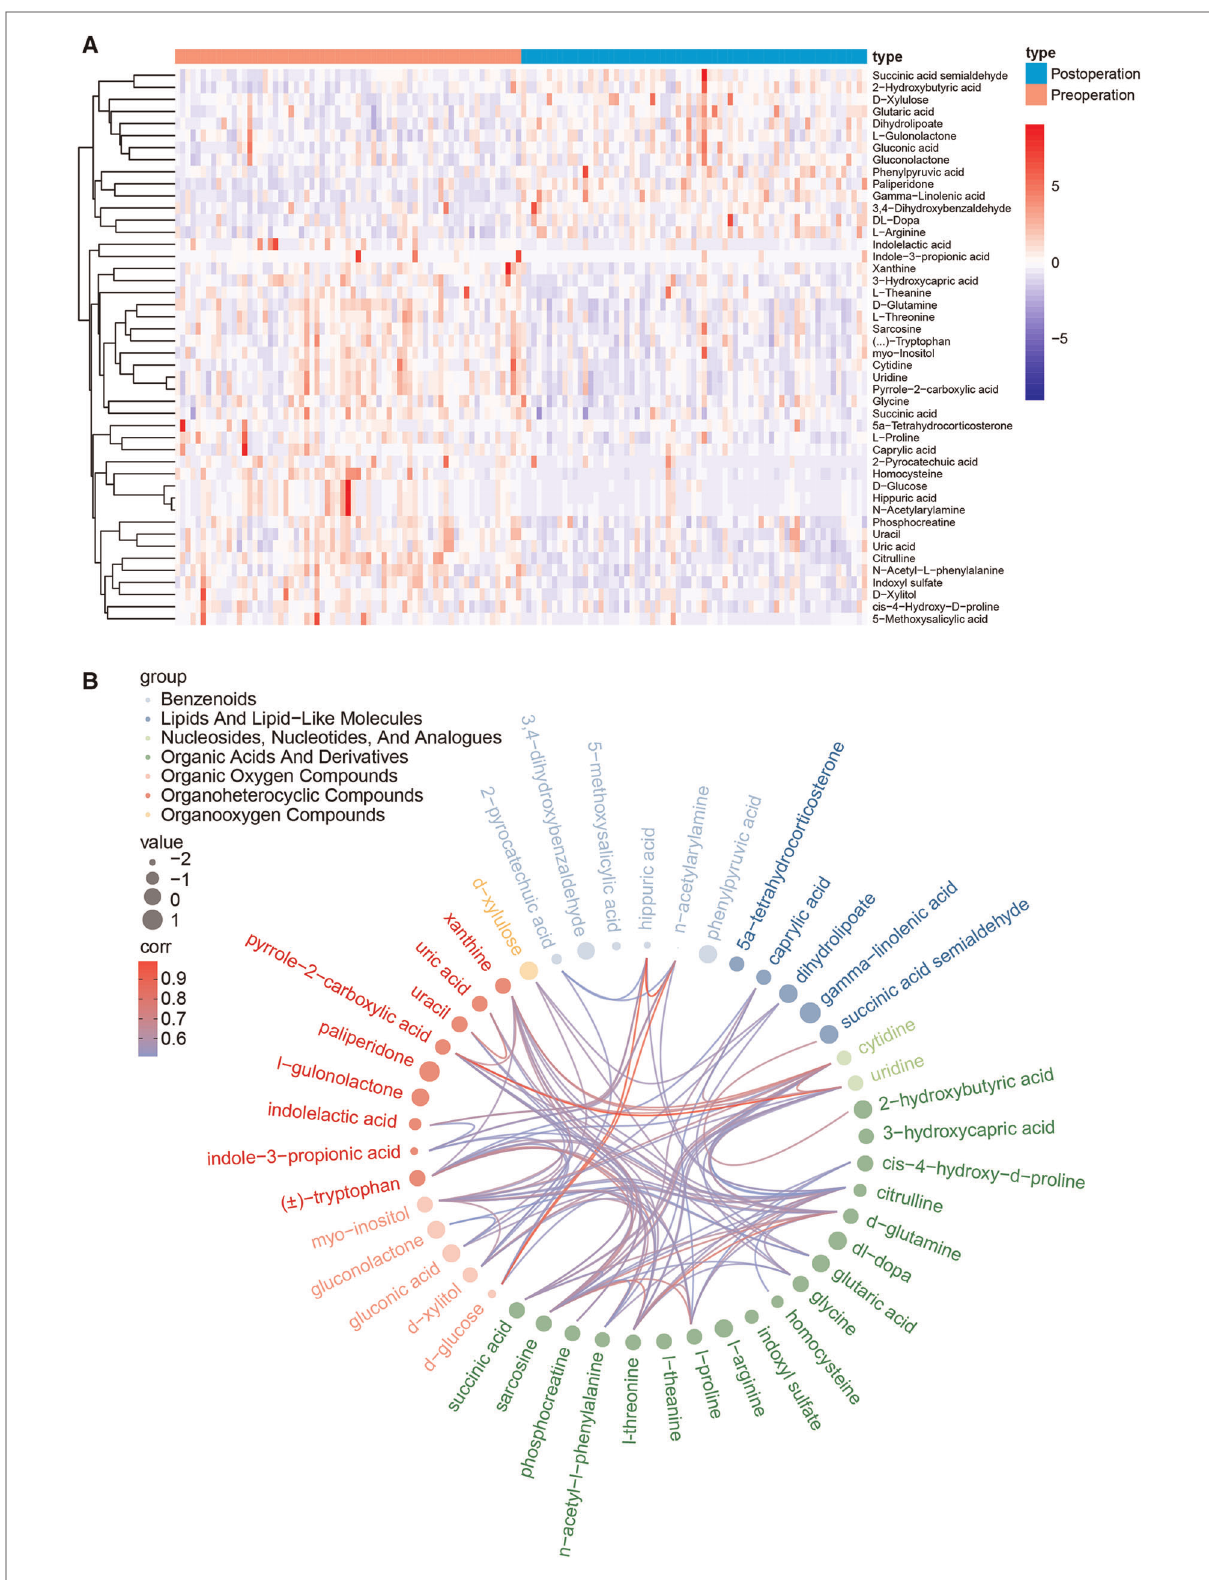
FIGURE 2 ( A ) The heat map for the 46 critical metabolites between the pre- and postoperation groups, including 32 downregulated metabolites and 14 upregulated metabolites. ( B ) The correlation network of the 46 differentially expressed